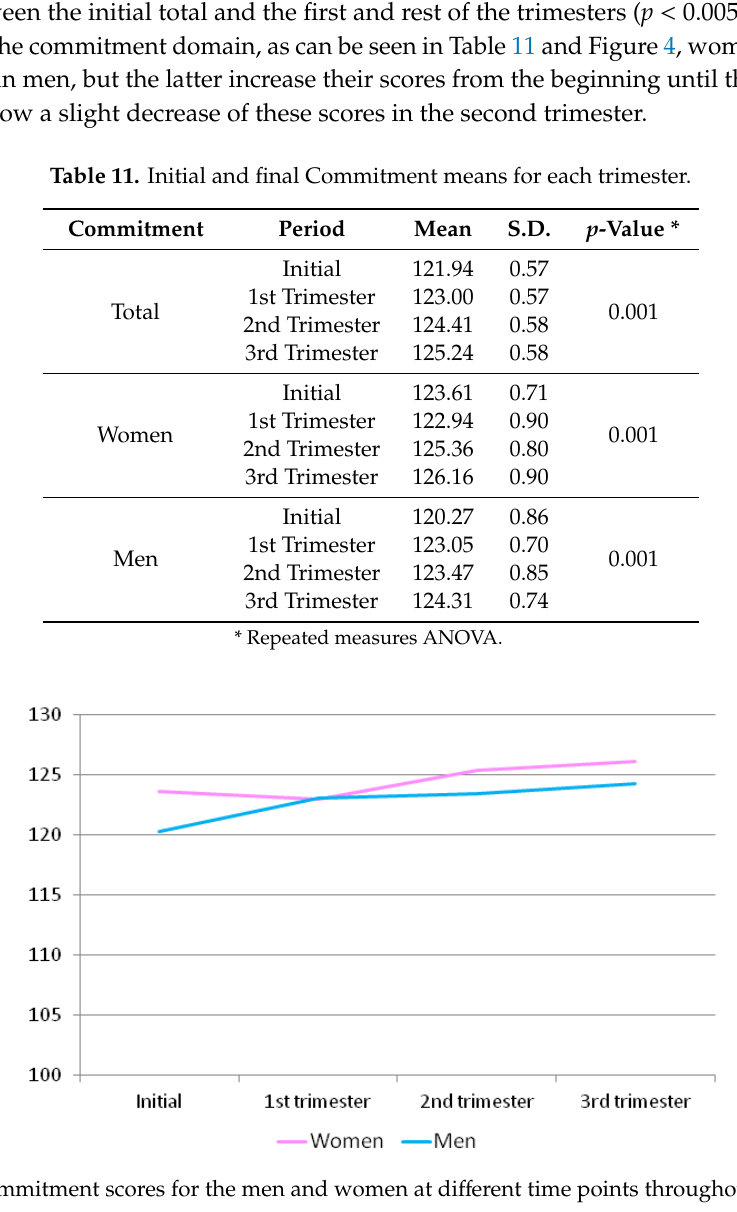
Table 12. Linear mixed-effects regression model (LRM-ME).